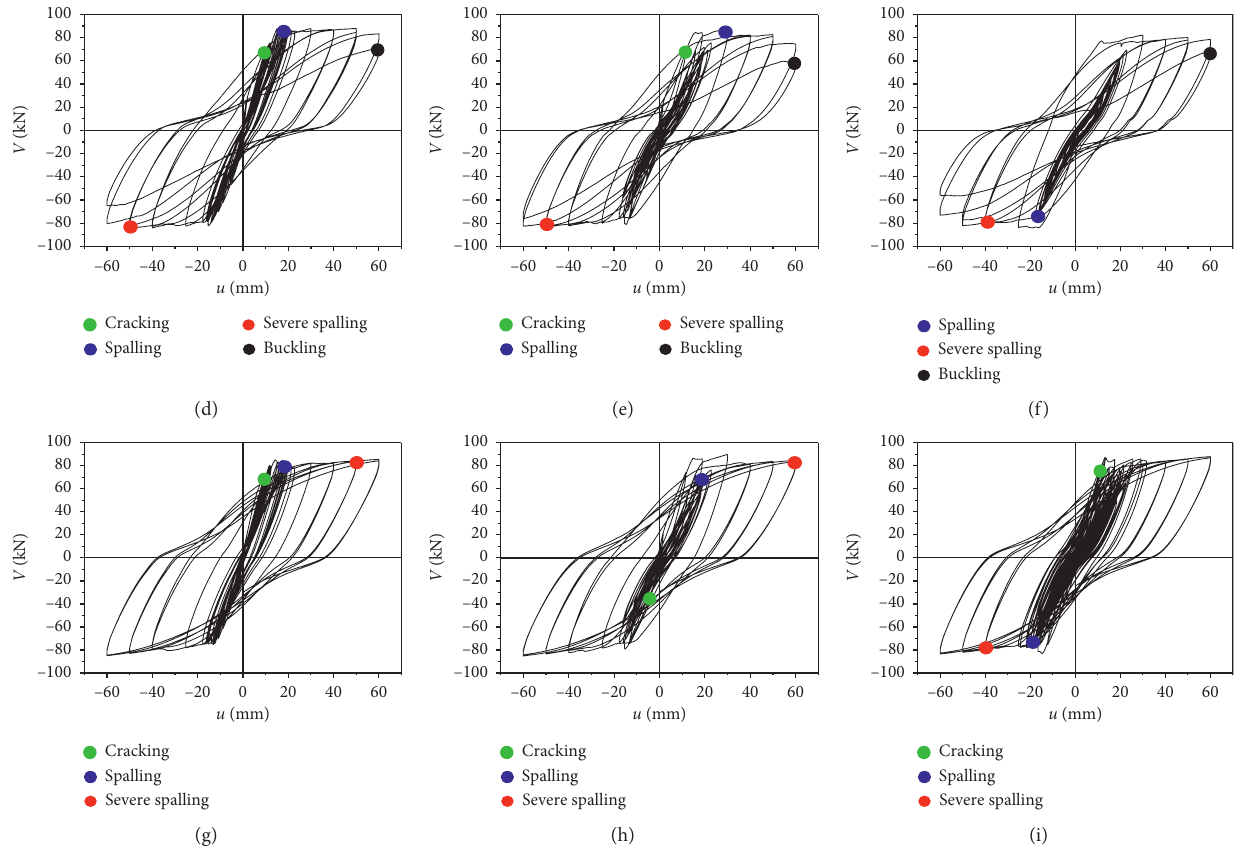
Figure 17: Hysteresis loops for specimens S1 to S9: (a) S1. (b) S2. (c) S3. (d) S4. (e) S5. (f) S6. (g) S7. (h) S8. (i)